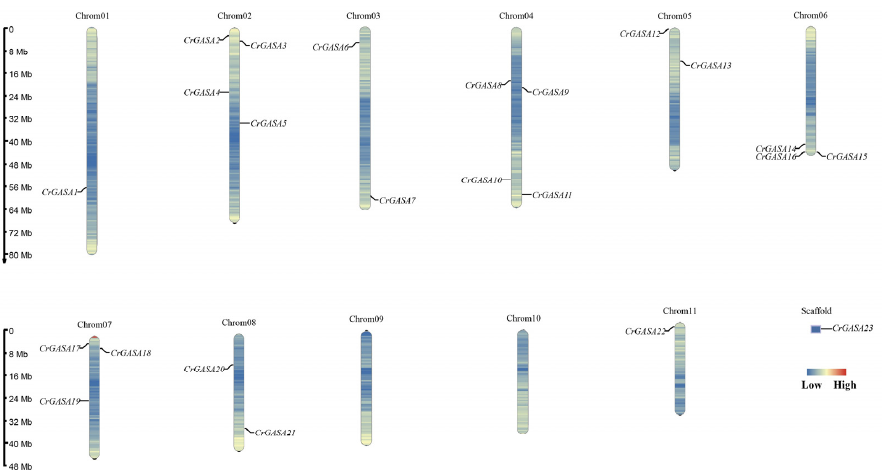
Figure 1. Locations of the twenty-three CrGASA s on eleven chromosomes and one scaffold of C. rosea genome.